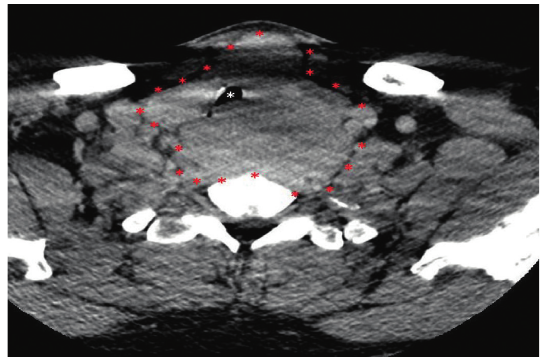
Figure 1: Enhanced axial computed tomography image at the level of the upper trachea demonstrating a large thyroid mass (red asterisks) resulting in compression and right lateral displacement of the trachea (white asterisk).